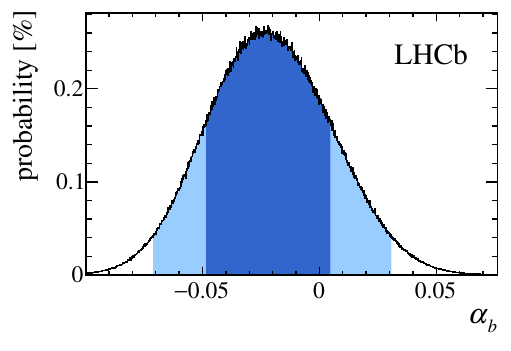
Figure 5 . Measured transverse production polarisation of the (cid:3) 0 p centre-of-mass energy, s , of the data set. The points indicate the most probable value and the shaded regions the 68% and 95% credibility level intervals.